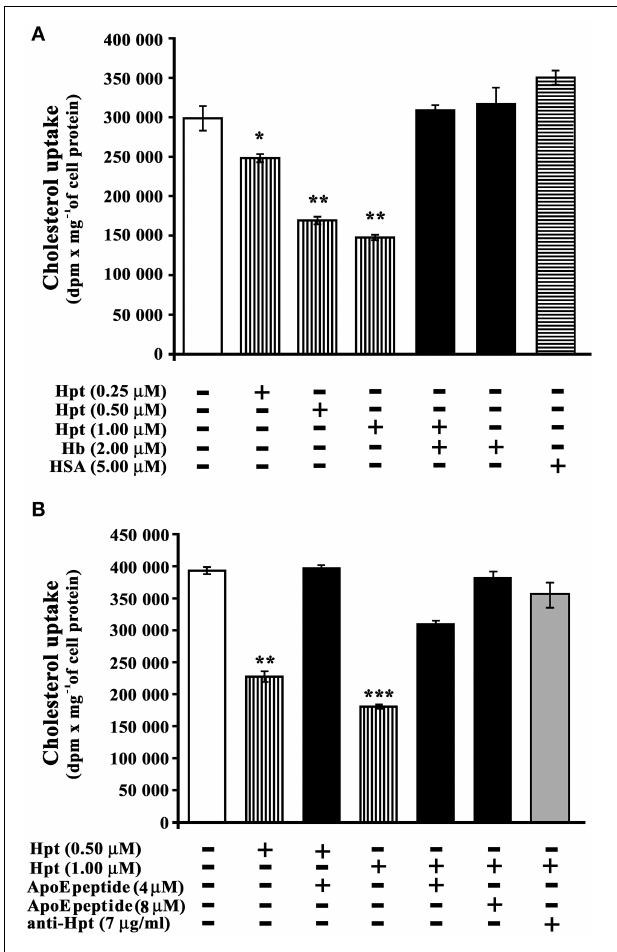
FIGURE 4 | Hpt effect on ApoE-mediated cholesterol incorporation. (A) Differentiated SHSY5Y were incubated into 96-well plate (3h; 8 × 10 3 cells per well) with proteoliposome suspension containing [ 3 H]-cholesterol, phosphatidylcholine, and 10nM ApoE. The assay was performed in the absence (open bar, control) or presence of different amounts of Hpt (0.25, 0.5 or 1 μ M; bars with vertical lines). Control experiments were also carried out in presence of Hb (2 μ M; full bar) or HSA (5 μ M, bar with horizontal lines). After incubation, the cells were lysed for measurement of their radioactivity and protein concentration. The amount of cholesterol internalized was measured as dpm permg of cell protein. Significant differences from control are indicated ( ∗ p < 0 . 05; ∗∗ p < 0 . 001). The samples were analyzed in triplicate, and the data are expressed as means ± s.e.m. (B) Differentiated SHSY5Y were incubated into 96-well plate (3h; 8 × 10 3 cells per well) with proteoliposome suspension containing [ 3 H]-cholesterol, phosphatidylcholine, and 10nM ApoE. The assay was performed in the absence (open bar, control) or presence of different amounts of Hpt (0.5 or 1 μ M; bars with vertical lines). Control experiments were carried out in presence of 0.5 μ M Hpt and 4 μ M ApoE mimetic peptide ( 131 EELRVRLASHLRKLRKLRLL 150 ; full bar), or in presence of 1 μ M Hpt and different amounts of ApoE mimetic peptide (4 or 8 μ M, full bars), or in presence of 1 μ M Hpt and mouse anti-human Hpt IgG (7 μ g/ml, gray bar). After incubation, the cells were lysed for measurement of their radioactivity and protein concentration. The amount of cholesterol internalized was measured as dpm permg of cell protein. Significant differences from control are indicated ( ∗∗ p < 0 . 001; ∗∗∗ p < 0 . 0001). The samples were analyzed in triplicate, and the data are expressed as means ±